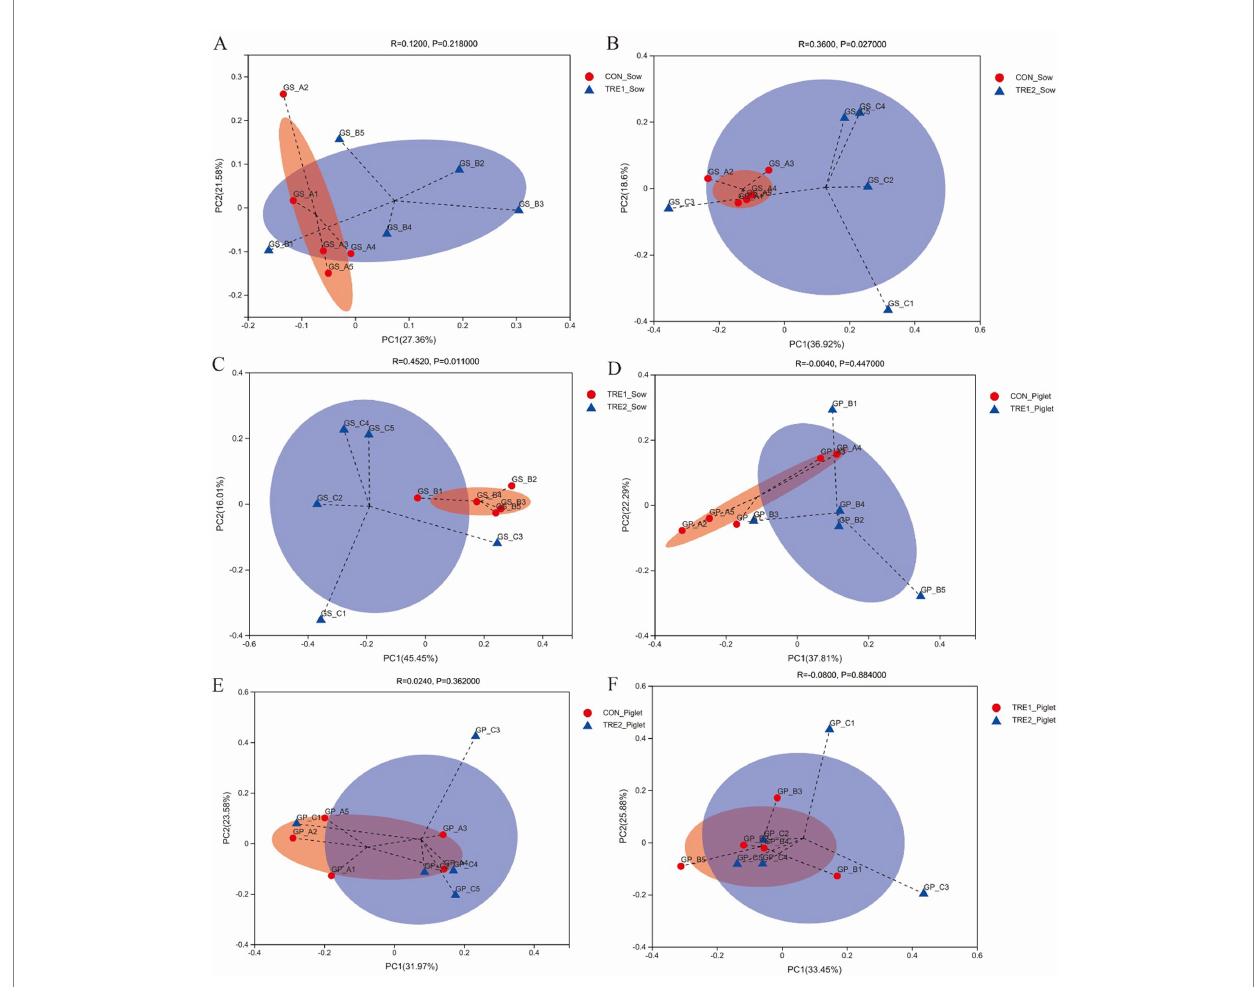
FIGURE 2 Beta-diversity analysis among experimental groups. PCoA for sow between the control group (CON_Sow) and TRE1 group (TRE1_Sow) (A) and TRE2 group (TRE2_Sow) (B) , and between TRE1 (TRE1_Sow) and TRE2 (TRE2_Sow) groups (C) . PCoA for piglets between the control group (CON_Piglet) and TRE1 (TRE1_Piglet) (D) and TRE2 (TRE2_Piglet) groups (E) , and between TRE1 (TRE1_Piglet) and TRE2 (TRE2_Piglet) groups (F) . N =